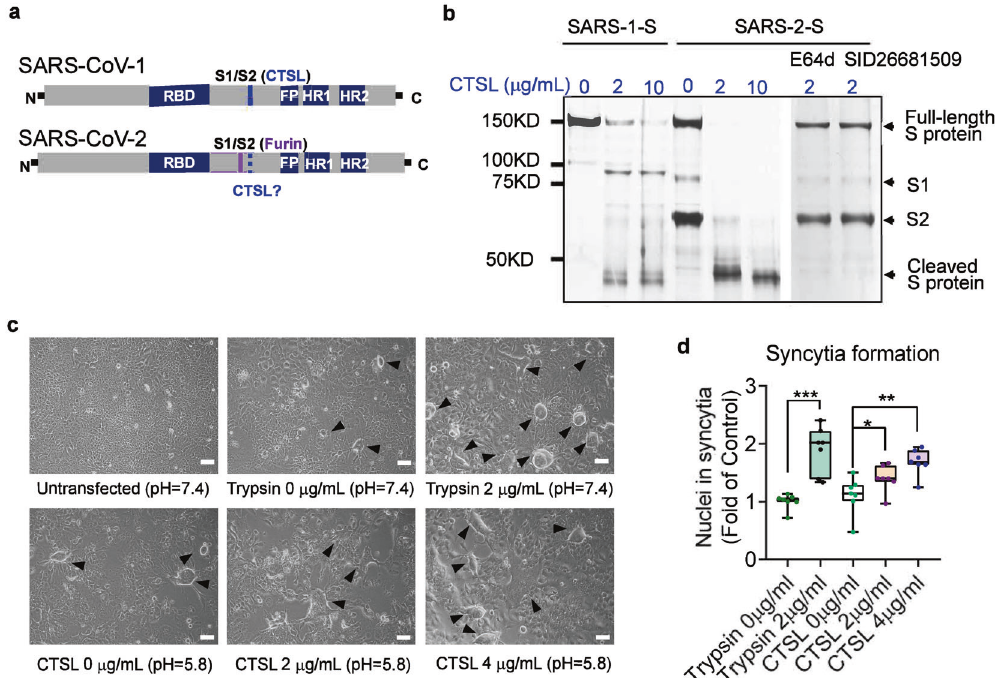
Fig. 4 CTSL cleaves the SARS-CoV-2 spike (S) protein, and this cleavage promotes cell – cell fusion. a Overview of the SARS-CoV-1 and SARS- CoV-2 S1/S2 cleavage sites. FP (fusion peptide), HR1 (heptad repeat 1), and HR2 (heptad repeat 2) are units of the S2 subunit that function in membrane fusion. b Analysis of CTSL-mediated S-protein cleavage. Puri fi ed SARS-CoV-1 or SARS-CoV-2 S protein was incubated in the presence or absence (assay buffer, pH = 5.5) of CTSL (2 or 10 μ g/ml in assay buffer, pH = 5 .5) at 37 °C for 1 h. The reaction system of 2 μ g/ml CTSL was further supplemented with CTSL inhibitors (20 μ M E64d or 20 μ M SID 26681509), as indicated. Proteins were subjected to SDS-PAGE and detected by silver staining. Representative data from three independent experiments are shown. c Syncytium-formation assay: Huh7 cells were untransfected (Null) or transfected with plasmid to express the SARS-CoV-2 S protein. Cells were incubated in the presence or absence (PBS, pH = 7.4) of trypsin (2 μ g/ml in PBS, pH = 7.4) or in the presence or absence (PBS, pH = 5.8) of CTSL (2 or 4 μ g/ml in PBS, pH = 5.8)